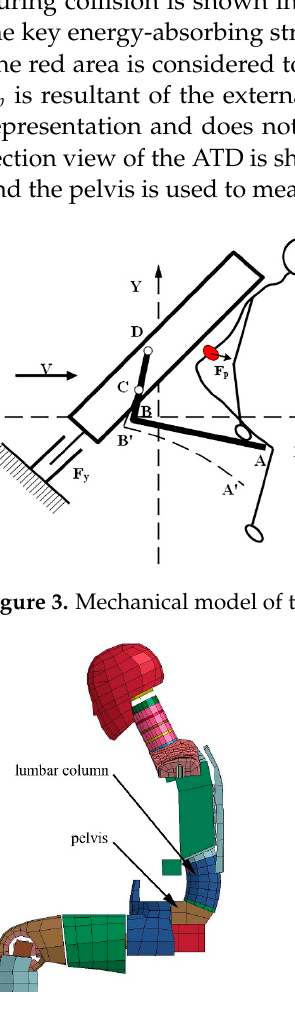
Figure 4. The section view of the FEM model of the Hybrid III 50th Percentile Male ATD.